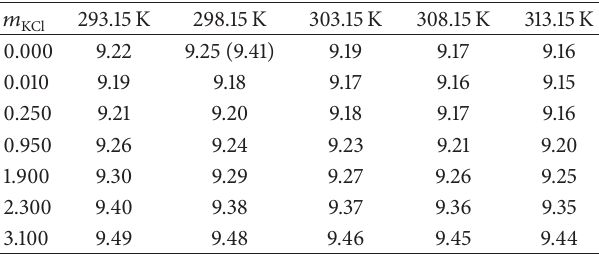
Table 1: Experimental protonation constant (log 𝐾 H 1 ± 0.01 ) of L1, in KCl of different ionic strength and at different